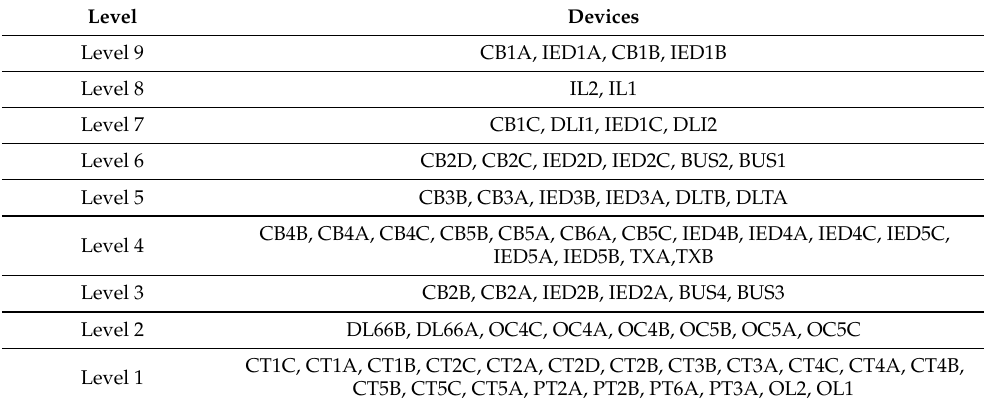
Table 9. Criticality ranks of substation